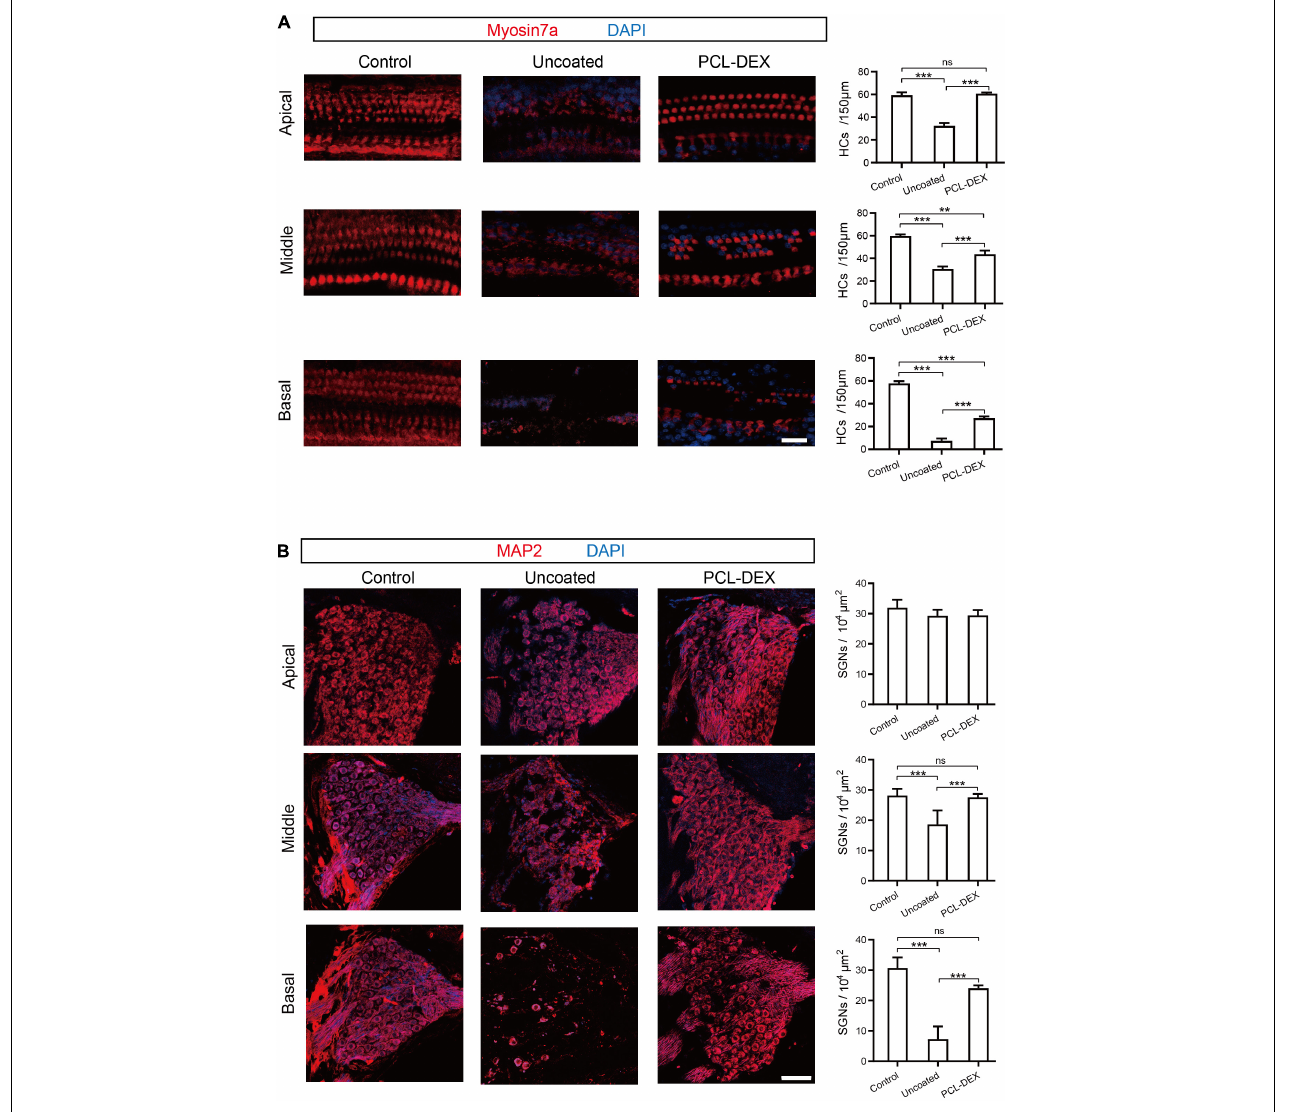
FIGURE 6 | The effects of different implant treatments on HCs and SGNs. (A) Representative immunofluorescence staining for myosin 7a (red) as a marker for HC (left panel) and HC density (right panel) at the basal, middle, and apical turns from cross sections of the cochlea before (control) and 5 weeks after implantation with pristine and PCL-DEX electrodes. Scale bar = 20 µ m. (B) Representative immunofluorescence staining for MAP2 (red) as a marker for SGN (left panel) and SGN density (right panel) at the basal, middle, and apical turns from cross sections of the cochlea before (control) and 5 weeks after implantation with pristine and PCL-DEX electrodes. Scale bar = 30 µ m. The data are presented as the mean ± SE. ns: no significant difference, p > 0.05, n = 3 for each group. ** p < 0.01; *** p <